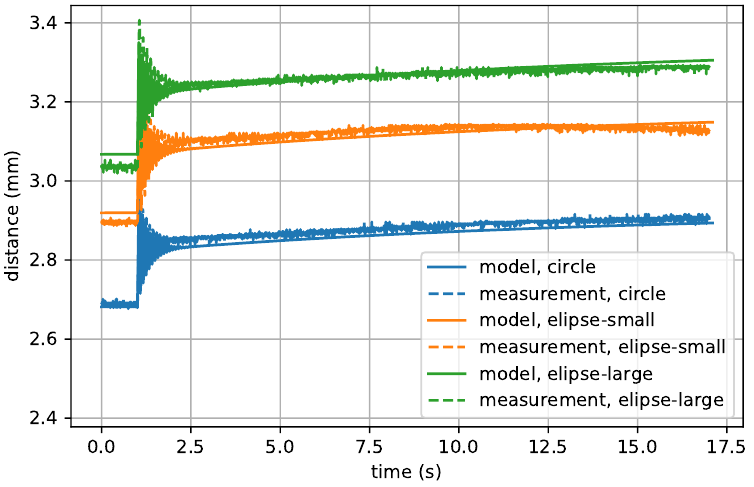
Figure 11. Response of the DEAP actuator for a step voltage signal from 0kV to 3.5kV with a load of